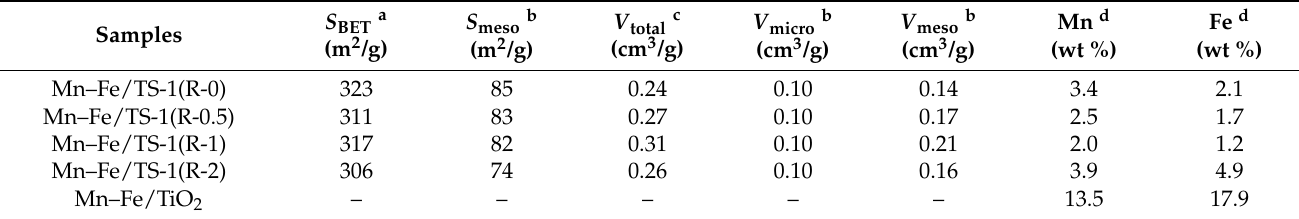
Table 1. Textural properties and elemental compositions of